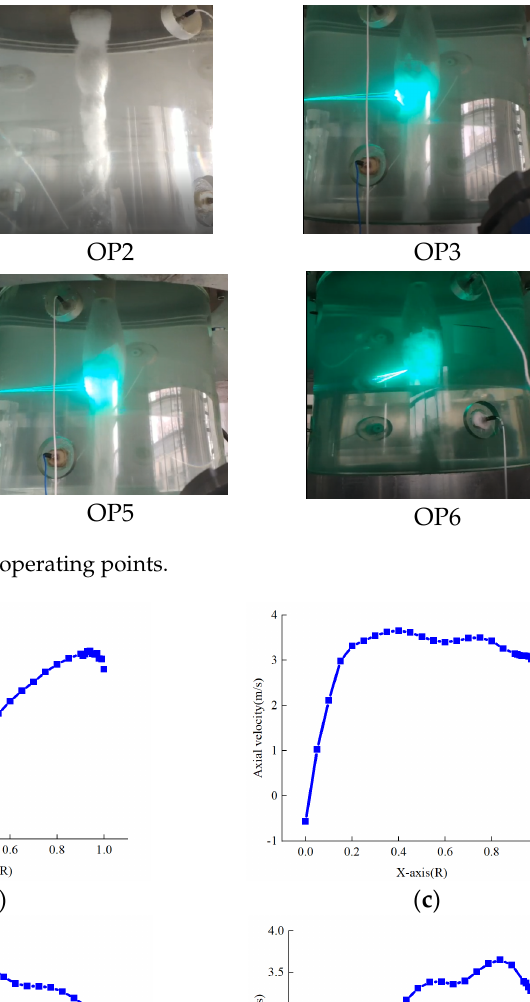
Figure 15. Trend of axial velocity distribution on the x-axis. ( a ) OP1, ( b ) OP2, ( c ) OP3, ( d ) OP4, ( e ) OP5, and ( f ) OP6.